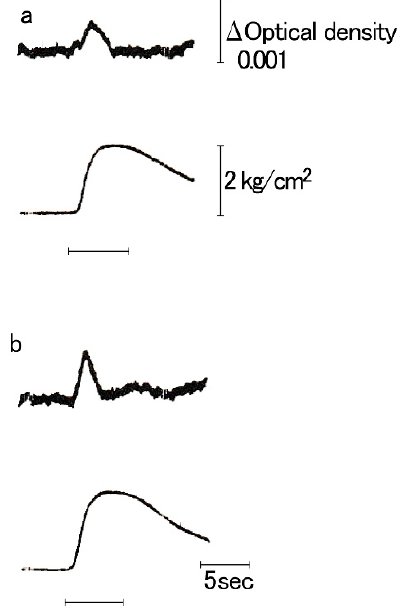
Figure 5. Simultaneous recordings of Ca 2+ transient ( a ) and isometric tension ( b ) during phasic contraction in the ABRM, elicited by a.c. current (horizontal bar) (Kometani and Sugi, 1978